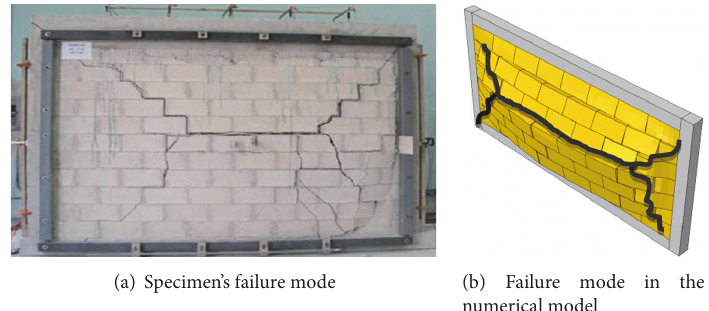
Figure 7: Damage severity and propagation in Varela-Rivera et al.’s specimen.